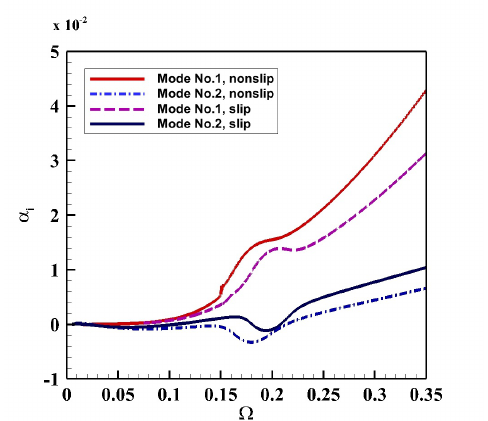
Figure 8. Modes No. 1 and No. 2 tracking between the slip and no-slip B.L. flows. The Y -axis α i represents the growth rates of the corresponding wave modes as a function of Ω = ω R , Ma e =